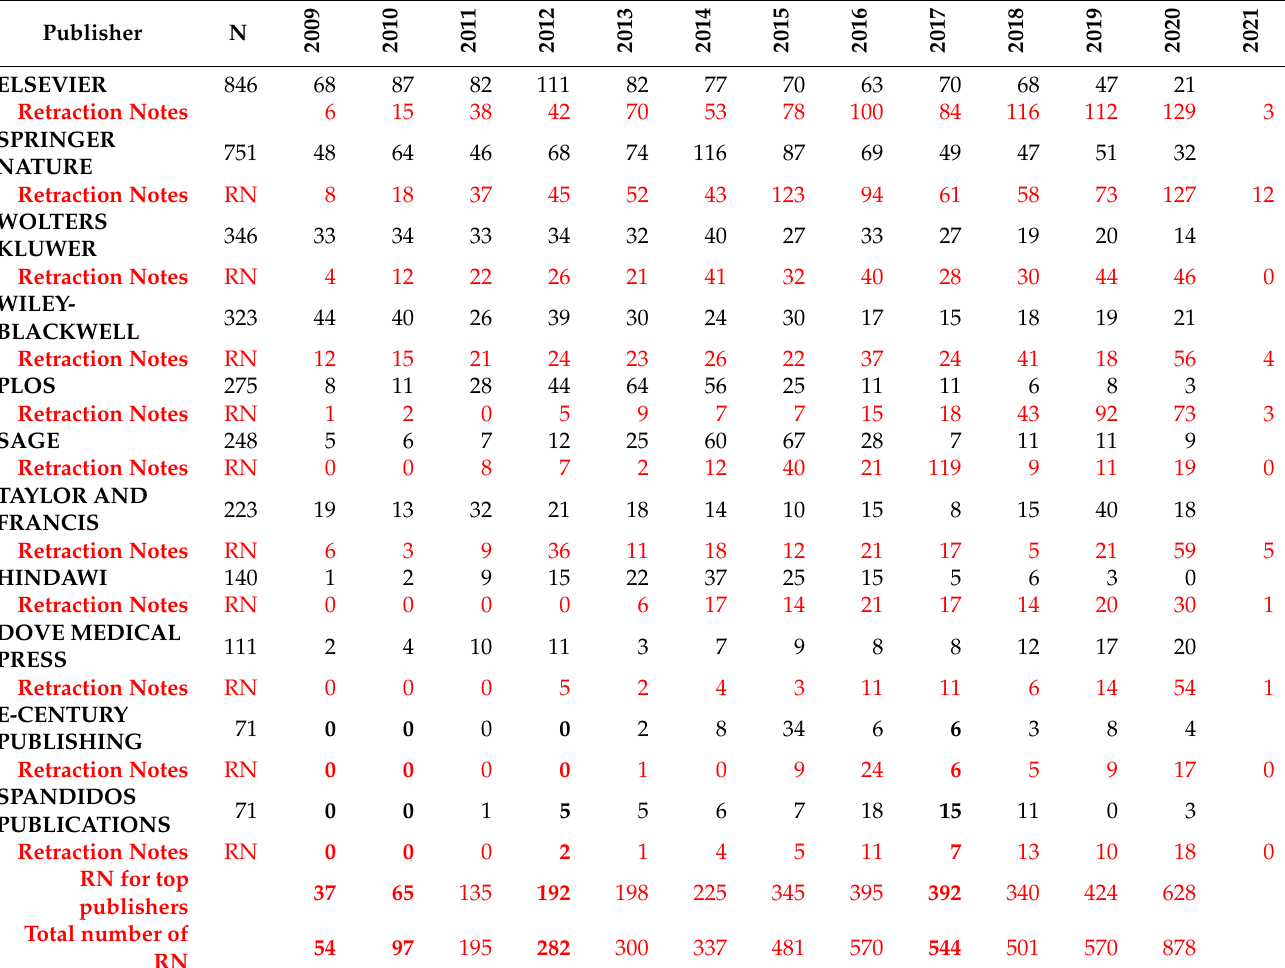
Table 3. Retracted articles and retraction notes by year for top 11